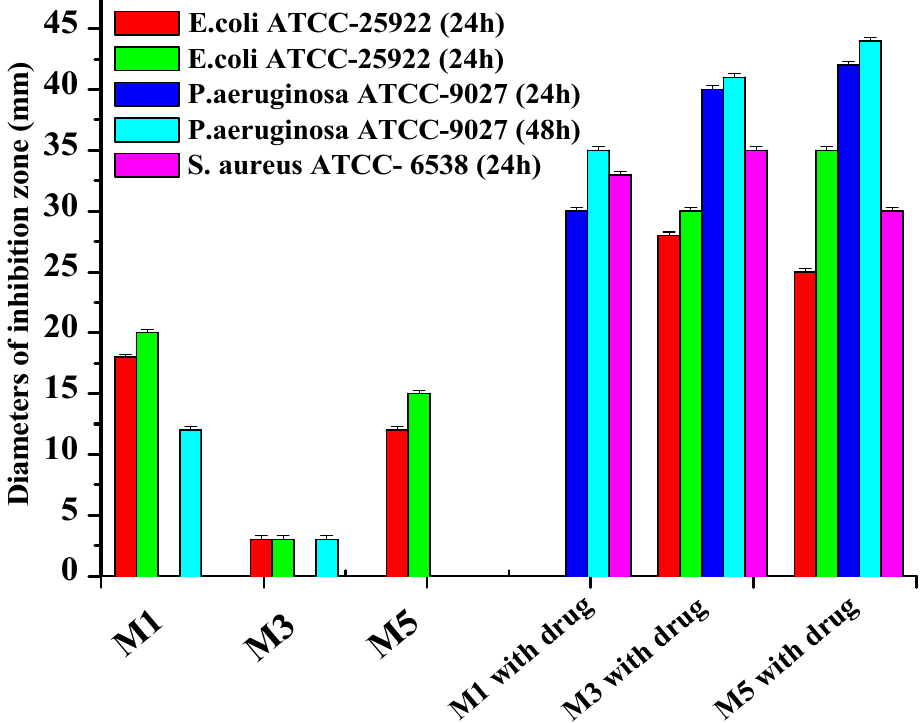
Figure 7. Inhibition zones of poly(DMA-co-AAc) hydrogels against GP ( Staphylococcus aureus ) and GN ( E. coli and P. aeruginosa bacteria ).